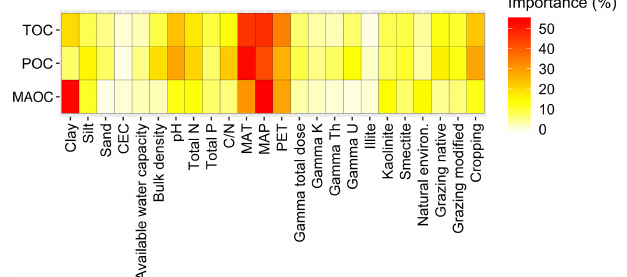
Figure 7. Importance of the environmental variables that contribute to potential changes in total, particulate and mineral-associated C organic C (TOC, POC and MAOC) by changing C inputs. Climatic variables, i.e. mean annual temperature (MAT), mean annual total precipitation (MAP) and potential evapotranspiration (PET), are av- eraged over a period of 1991–2010. CEC is the cation exchange ca- pacity of a soil. The importance of each soil variable was assessed based on the usage of each individual variable in the rule conditions and the model for